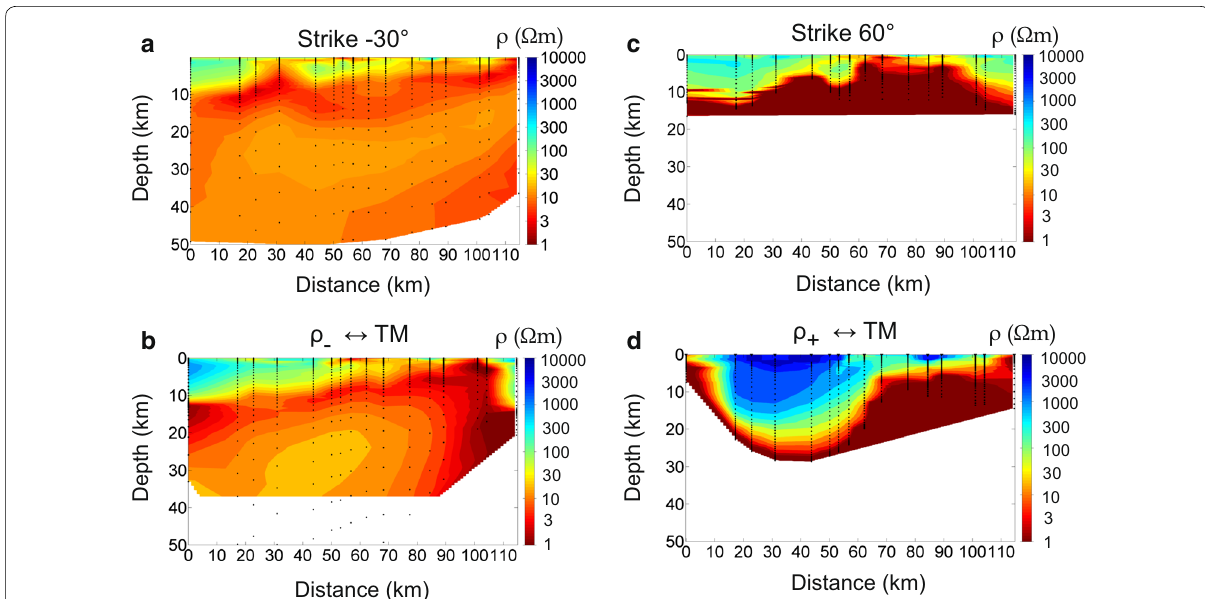
Fig. 13 Images of the subsurface obtained by inverting the four computed TE apparent resistivity pseudo‑sections shown in Figs. 5, 6, 7 and 8. These images are in the same order as those in Fig. 10. a and c are for the two fixed angles and b and d for the related invariants. The inversion was performed using the 1D formula of Eq. 10 for harmonic averages of resistivity between two depths h 2 and h 1 . The dots correspond to the geometric √ h 1 h mean h m =